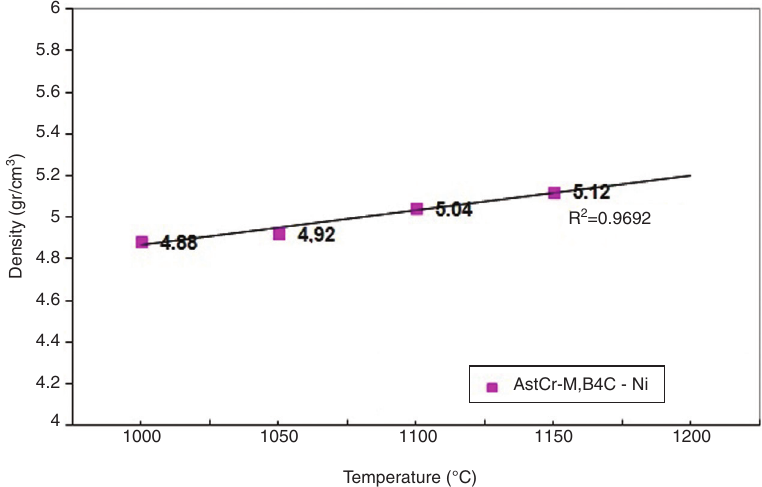
C-Ni composite sintered in furnace at 1150 ° C. 4